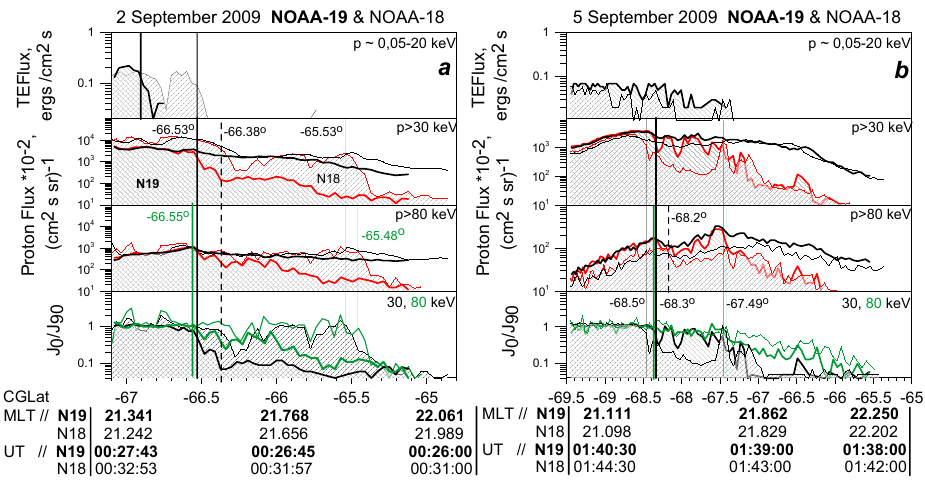
Figure 2. Examples of latitudinal profiles of time-evolving precipitation near the isotropy boundary observed by NOAA-19 (bold lines) and NOAA-18 (thin lines) observed on 2 September 2009 with a 5min delay (a) and on 5 September (b) with an ∼ 4min time delay. Black and green color of the lines in the bottom panel as well as vertical lines correspond to the 30 and 80keV energy channels. Red lines show the precipitated flux.